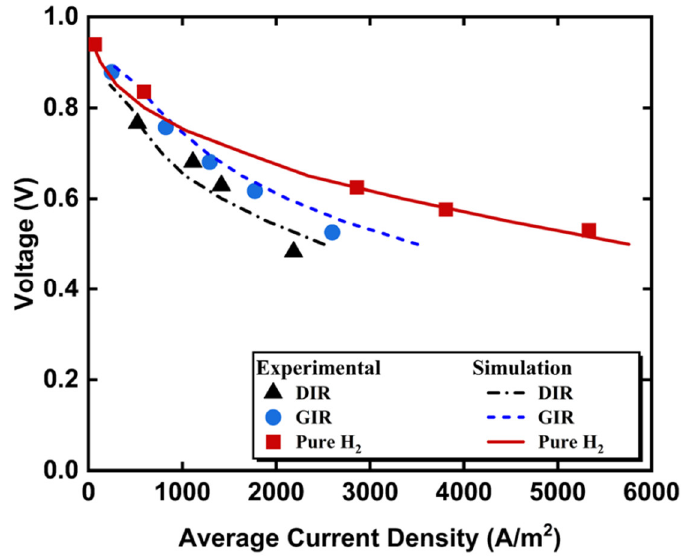
Figure 3. The operating voltage for tubular SOFC as a function of the current density at different operating conditions from our simulation and the experimental data [39].